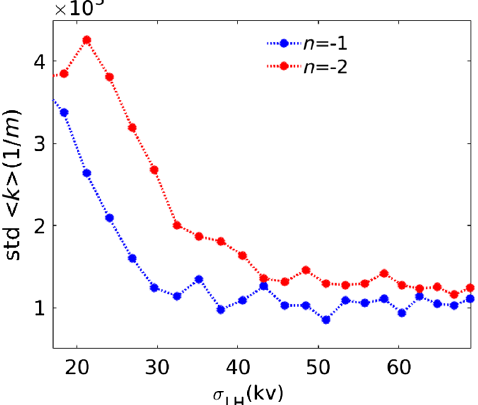
factor.FIG. 3. Comparison of standard deviation of frequency fluc- tuations of 50 shots n ¼ − 1 (blue) and 100 shots n ¼ − 2 (red) configurations in EEHG experiment respect to the different induced LH energy spread. EEHG harmonic is 30 ( λ 8 . 8 nm). The FEL parameters are same as in Fig.